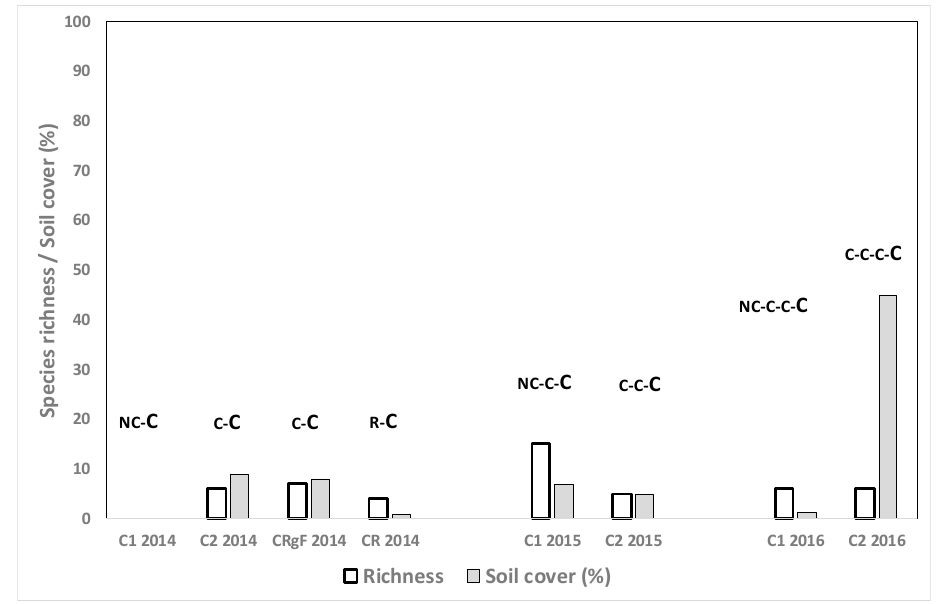
Figure 3. Weed species richness and total weed soil cover (%) for the cereal crops in the spring surveys. The letters show the crops from 2013 until the sampling moment, the sampled crop being the last of the rotation (in larger letters). R: rice Nc: no crop, C: cereal.